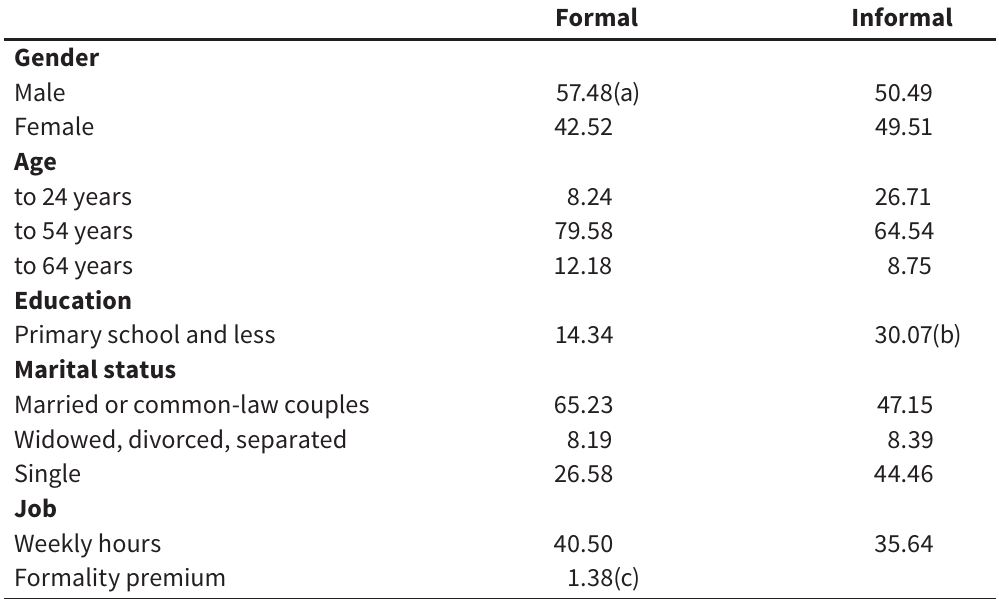
Socio-demographic characteristics of employment Formal